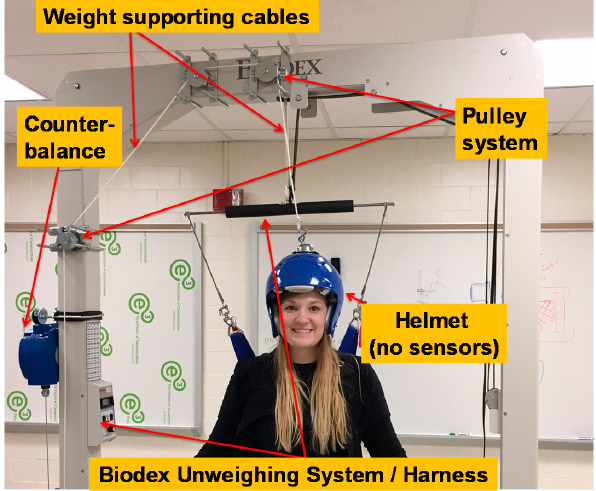
Figure 5. Generation 1 current support prototype with weighted helmet allowing for much more freedom. The subject/patient. Counterbalance currently supports up to 10 kg but can be upgraded.